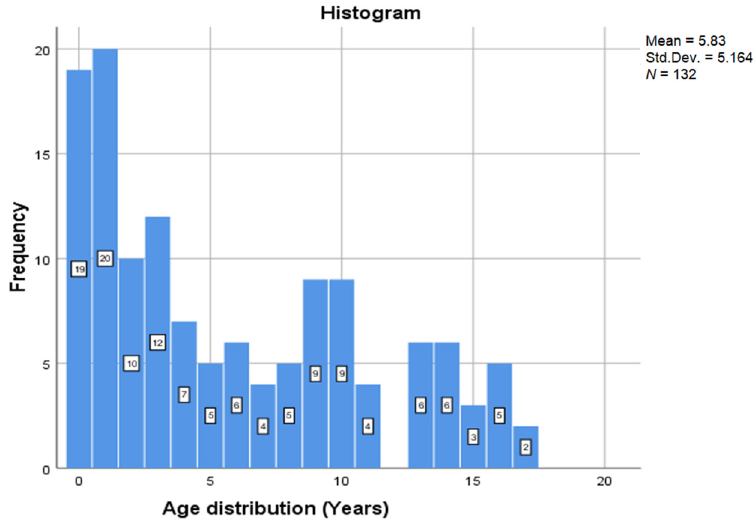
Figure 1. Age distribution.